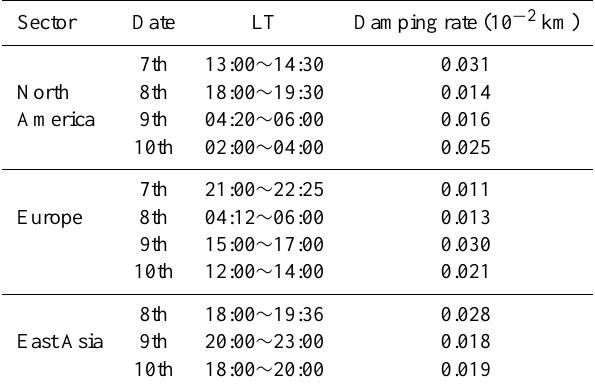
Table 3. The damping rates of the LSTIDs detected in the three sectors on 7 ∼ 10 November